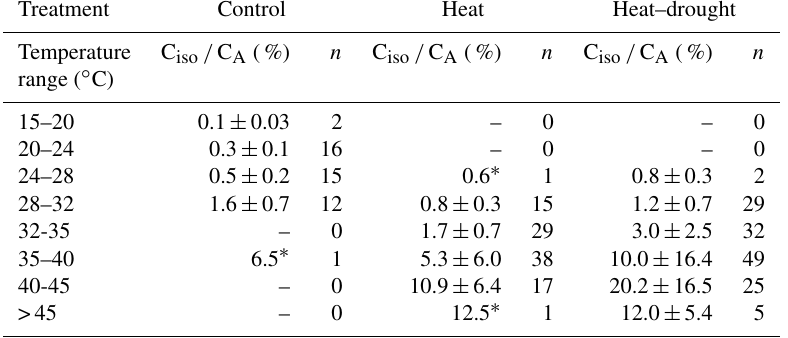
Figure 5. Dependency of isoprene emissions on temperature ( a ; isoprene emissions for PAR>100µmolm − 2 s − 1 , normalized to PAR = 500µmolm − 2 s − 1 ) and light ( b ; normalized to T = 30 ◦ C) in black locust trees during the heatwaves. Filled symbols are bin av- erages for predefined temperature or light classes in the control (black), heat (red) and heat–drought treatment (blue). Single data points are depicted by open symbols. Solid lines are derived by nonlinear regression of averaged isoprene emissions to temperature and light response functions (Eqs. 7 and 8). Dashed lines are the respective 95% confidence intervals of the regression fits. For model parameters, see Table 4. Table 3. Ratio between assimilated carbon and carbon emitted as isoprene (C iso / C A ) averaged for different temperature ranges and treat- ments during the stress periods including the corresponding standard deviation (calculated using data points with PAR>50µmolm − 2 s − 1 only). The number of values ( n ) included in the calculation of the class averages is given to the right of each C iso / C A column. C iso / C A values were only significantly different ( p< 0 . 05, u -test) between the control and heat treatment in the temperature range 28–32 ◦ C. Treatment Control Heat